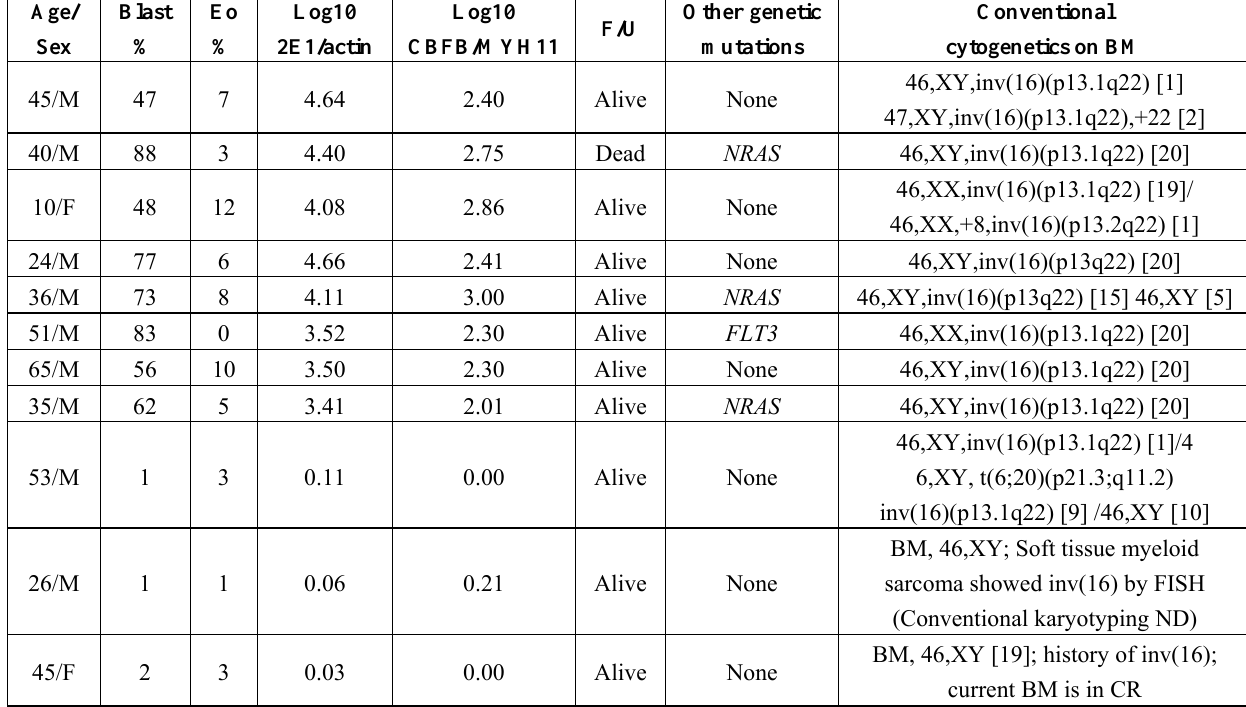
Table 1. Clinicopathologic features of patients with AML with inv(16) for mRNA assessment.